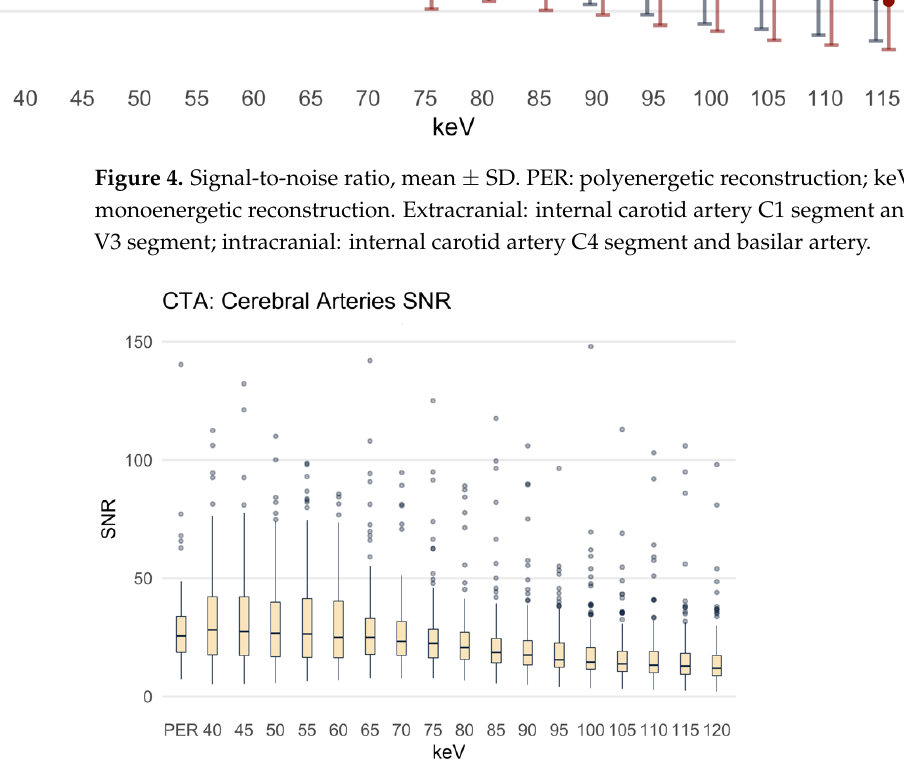
Figure 4. Signal-to-noise ratio, mean ± SD. PER: polyenergetic reconstruction; keV: keV level of the monoenergetic reconstruction. Extracranial: internal carotid artery C1 segment and vertebral artery V3 segment; intracranial: internal carotid artery C4 segment and basilar artery.